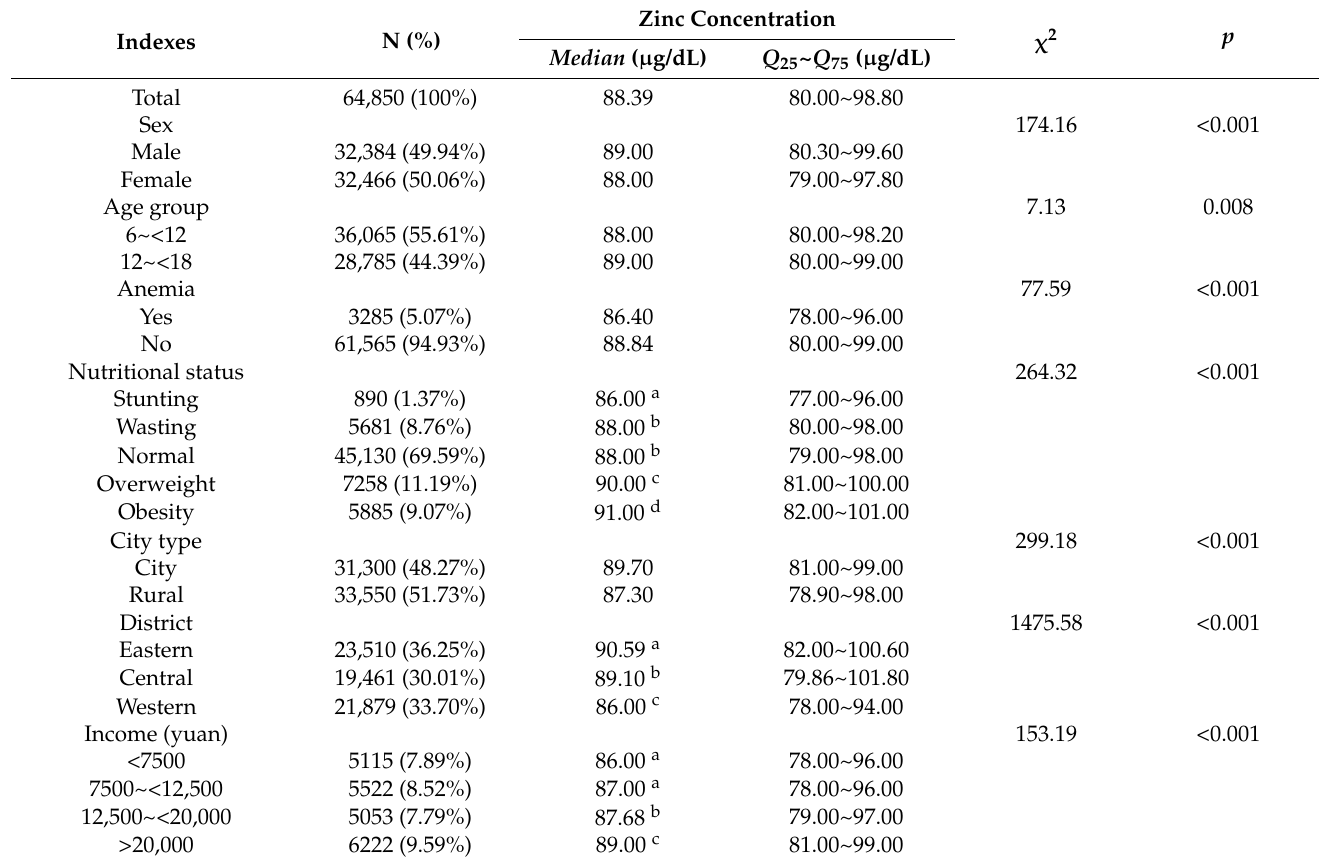
Table 1. Serum zinc levels of Chinese children under different stratified